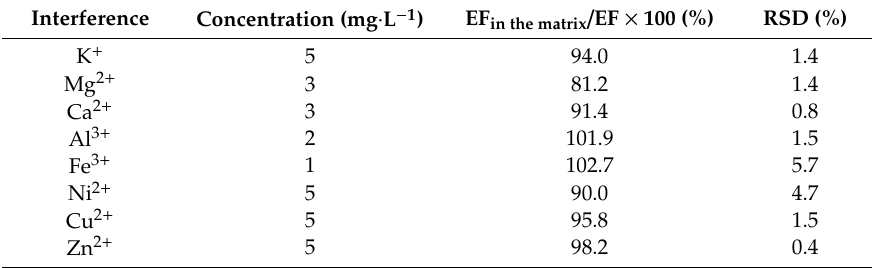
Table 2. Effect of interfering ions on EF in the matrix /EF of Cd 2+ ions. Experimental conditions: Cd 10 Table 2. E ff ect of interfering ions on EF in the matrix / EF of Cd 2 + ions. Experimental conditions: